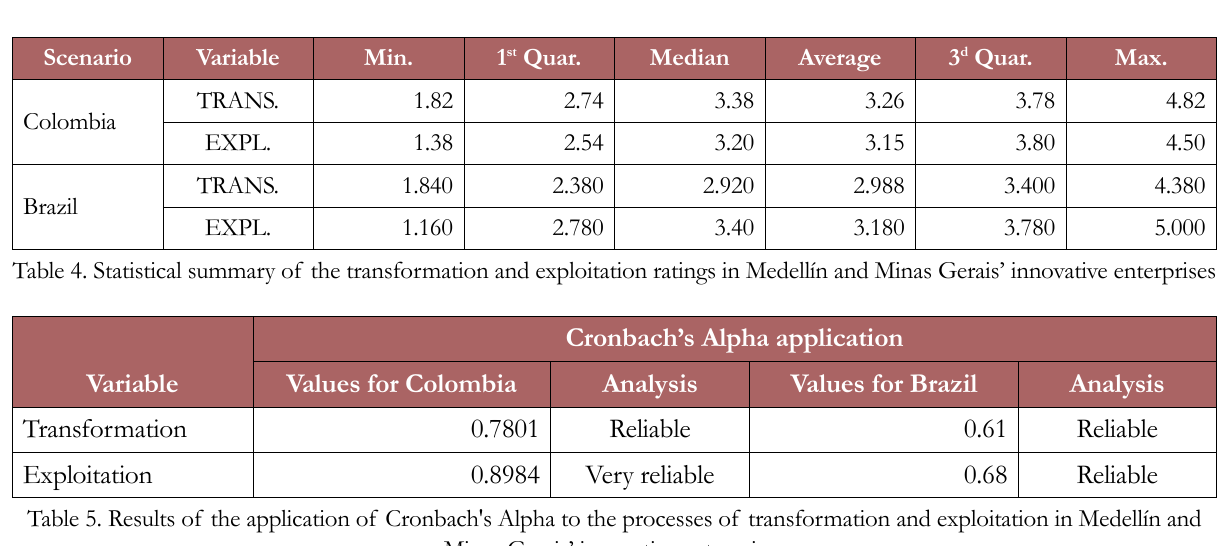
Table 5. Results of the application of Cronbach's Alpha to the processes of transformation and exploitation in Medellín and Minas Gerais’ innovative